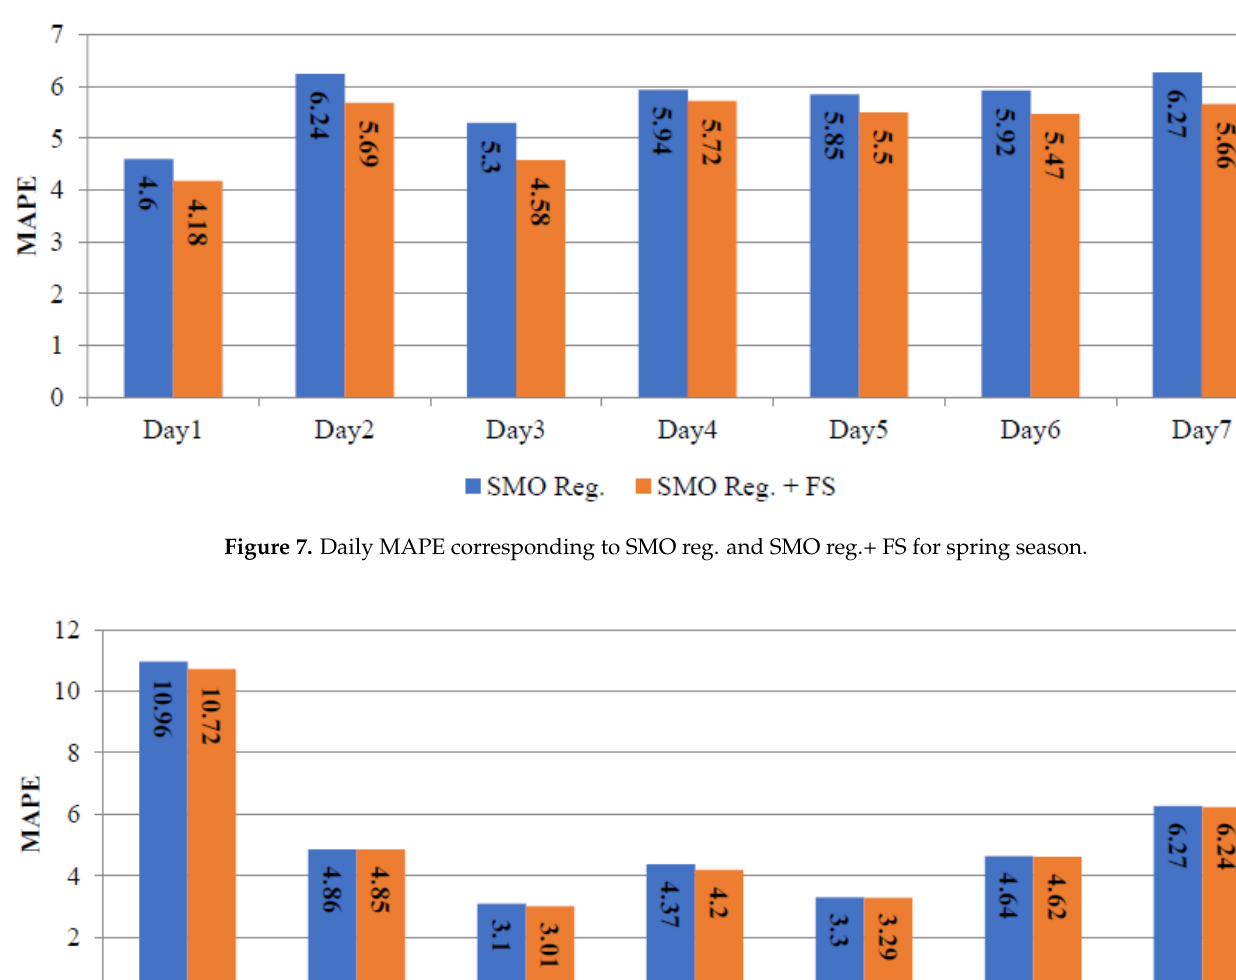
Figure 6. Daily MAPE corresponding to SMO reg. and SMO reg.+ FS for winter season.